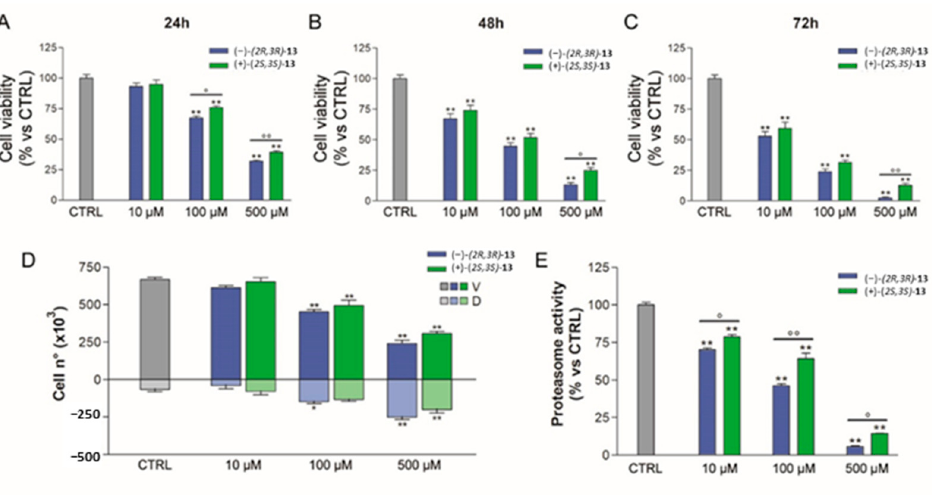
Figure 6. Effects of ( − )- (2R,3R) - 13 and (+)- (2S,3S) - 13 on RPMI 8226 cell viability, death and proteasome activity. MTT assay of RPMI 8226 cells treated for 24 ( A ), 48 ( B ) and 72 h ( C ) with different concentrations (10, 100 and 500 µM) of ( − )- (2R,3R) - 13 or (+)- (2S,3S) - 13 . ( D ) Trypan blue vital count assay of RPMI 8226 treated for 24 h with different concentrations (10, 100 and 500 µM) of ( − )- (2R,3R) - 13 or (+)- (2S,3S) - 13 . Both viable and dead cells were counted and plotted on the graph. ( E ) Proteasome activity at 24 h of RPMI 8226 cells treated with different concentrations (10, 100 and 500 µM) of ( − )-(2R,3R)- 13 or (+)-(2S,3S)- 13 . Data are represented as the mean ± SD of three independent experiments and are compared to untreated controls (CTRL). * p < 0.05 and ** p < 0.01 vs. respective CTRL; ° p < 0.05 and °° p < 0.01 vs. analogous concentration. Enantiomer ( − )- (2R,3R) - 13 showed a profile comparable with racemate in MTT and Trypan blue tests, whereas (+)- (2S,3S) - 13 showed less antiproliferative properties. Regarding proteasome inhibition, the same trend was observed, having ( − )- (2R,3R) - 13 and (+)- (2S,3S) - 13 IC 50 values of 90 ± 8 µM and 189 ± 17 µM, respectively. Computational results highlighted that the compounds 13 and 14 are well accommodated in the proteasome chymotrypsin-like site, establishing different kinds of interactions with the key residues of the proteasome chymotrypsin pocket (Figure 7). Figure 7. 3D representation of ( A ) ( 2R,3R )- 13 and ( 2S,3S )- 13 and ( B ) ( 2R,3R )- 14 and ( 2S,3S )- 14 complexed in the proteasome chymotrypsin pocket. The proteasome is shown as azure cartoon, the ( 2R,3R )- and the ( 2S,3S )- enantiomers are represented as green and yellow sticks, respectively. The residues involved in crucial contacts with the compounds are reported as azure carbon sticks. The water molecule is shown as red carbon sticks. Hydrogen bonds and salt bridges interactions are reported, respectively, as yellow and magenta dashed lines. By analyzing the binding mode of each enantiomer, we noticed that all compounds are involved in several interactions, such as hydrogen bond and salt bridge interactions with the proteasome chymotrypsin active site (Figure 7) and all of them bind to the pocket area in which ixazomib also binds.